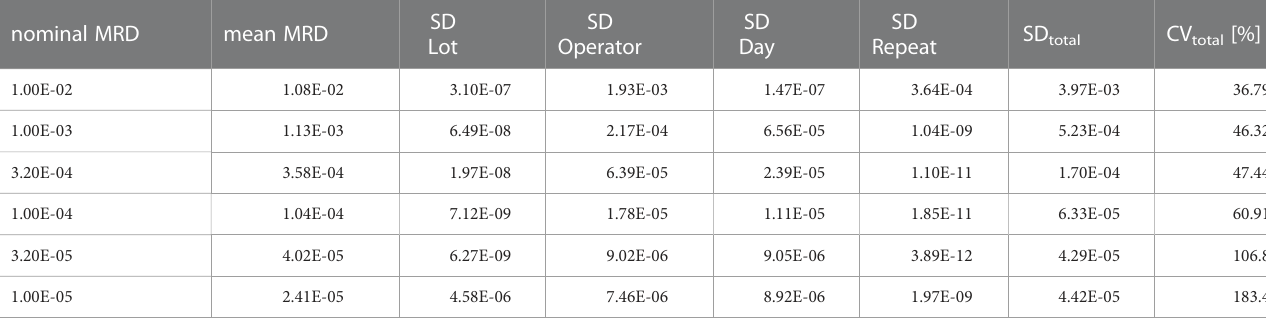
TABLE 3 Precision estimates derived from a mixed effects regression model of a spike-in experiment of different patient assays (n=3) for different random factors. nominal MRD mean MRD